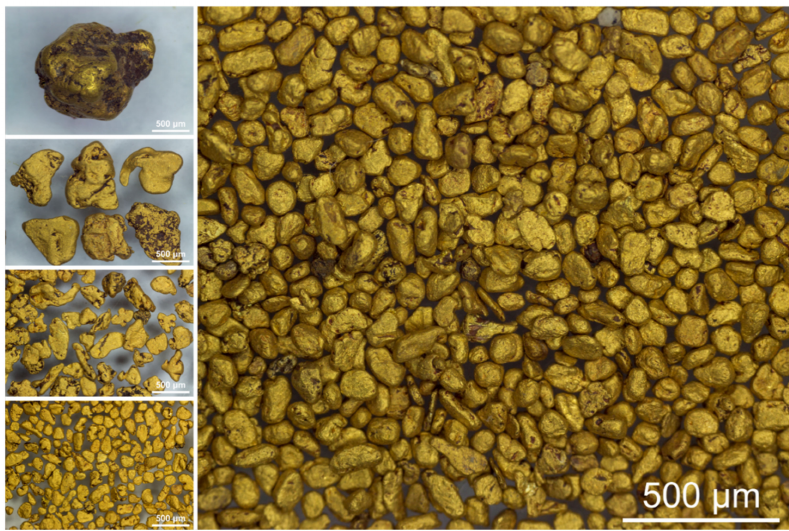
Figure 6. Native gold concentrate from the Gule River placer (photo by B. Lobastov).